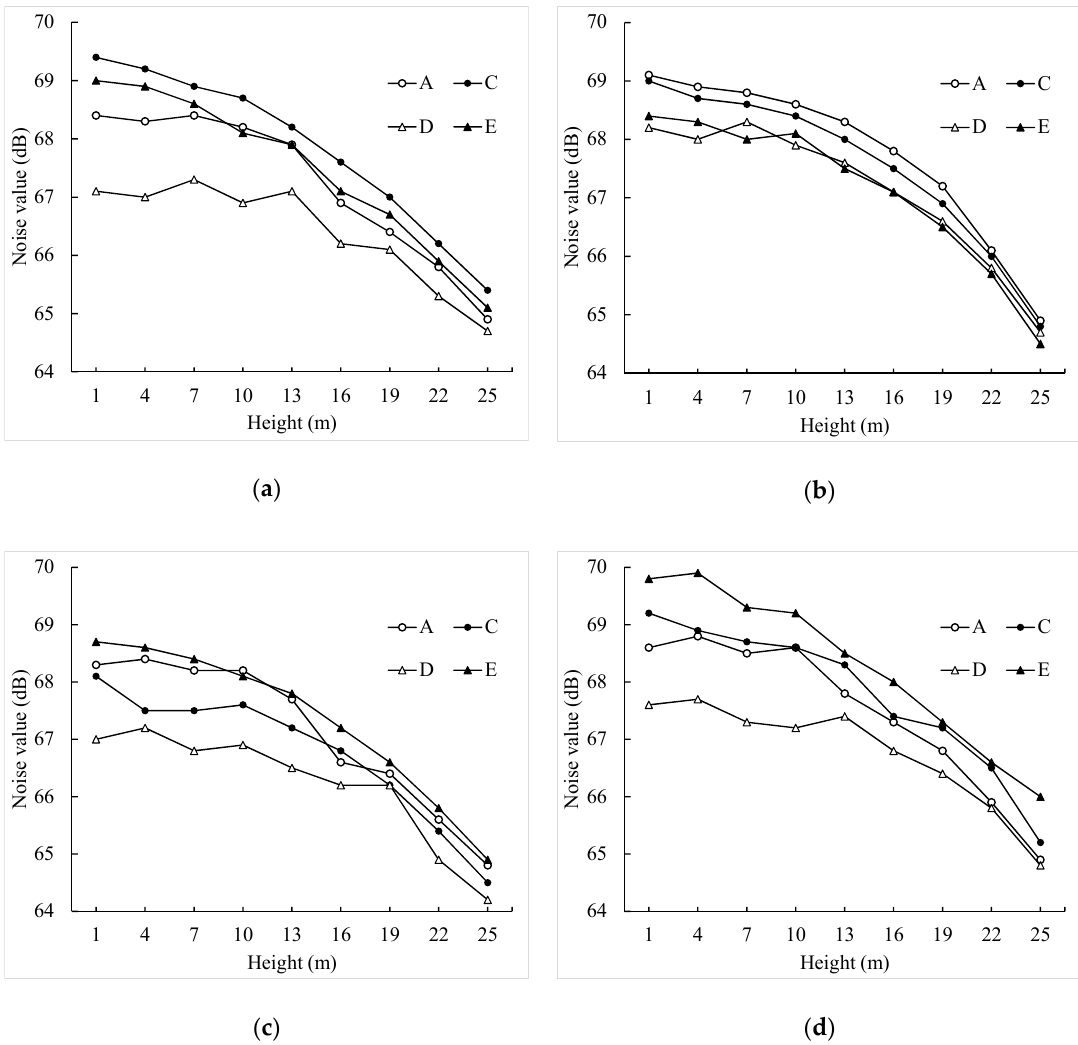
Figure 11. Noise value of different planes. ( a ) Façade a; ( b ) façade b; ( c ) façade c; ( d ) façade d.